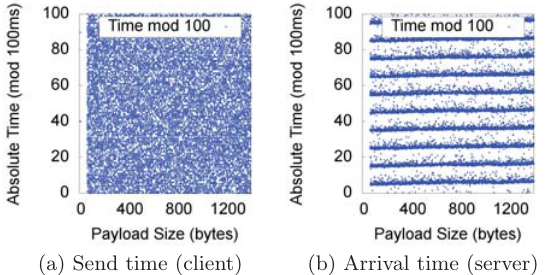
Figure 2: Effect of path bias onto random measure- ment samples: client send vs. server arrival timing identifies network period of 10 ms (tcpdump traces for HSPA uplink, timestamp modulo 100 ms).